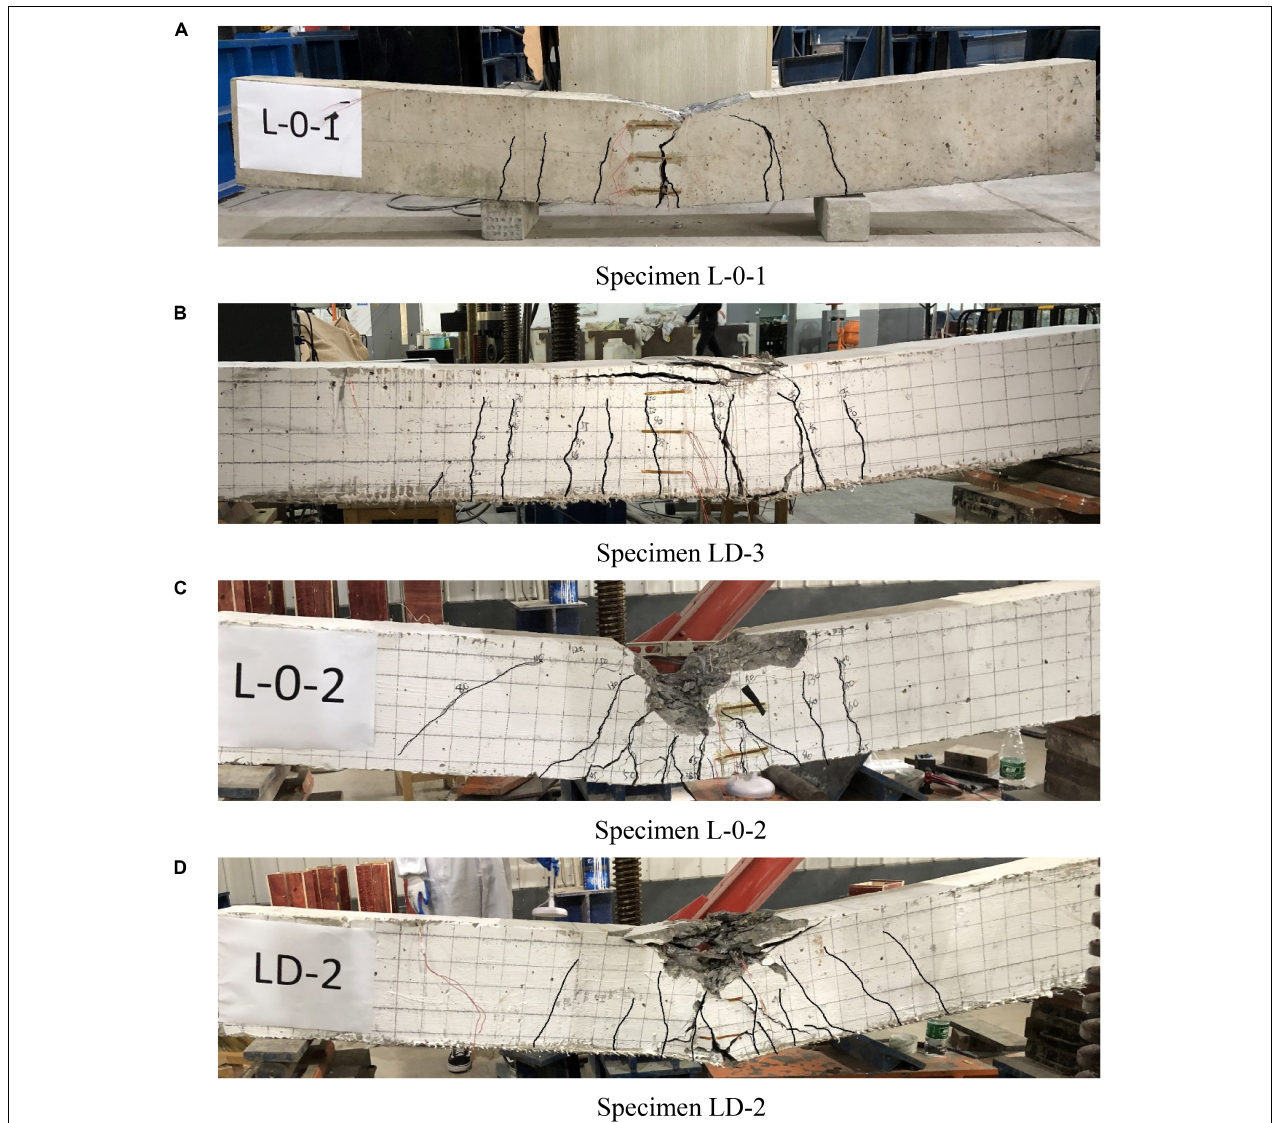
FIGURE 4 | Failure modes of specimens. (A) Specimen L-0-1. (B) Specimen LD-3. (C) Specimen L-0-2. (D) Specimen